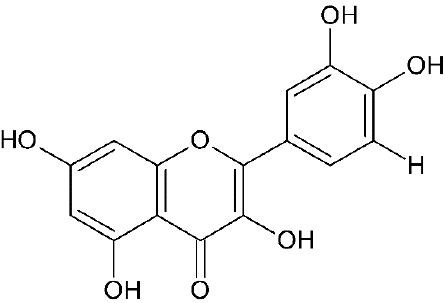
Fig. 1. Chemical structure of